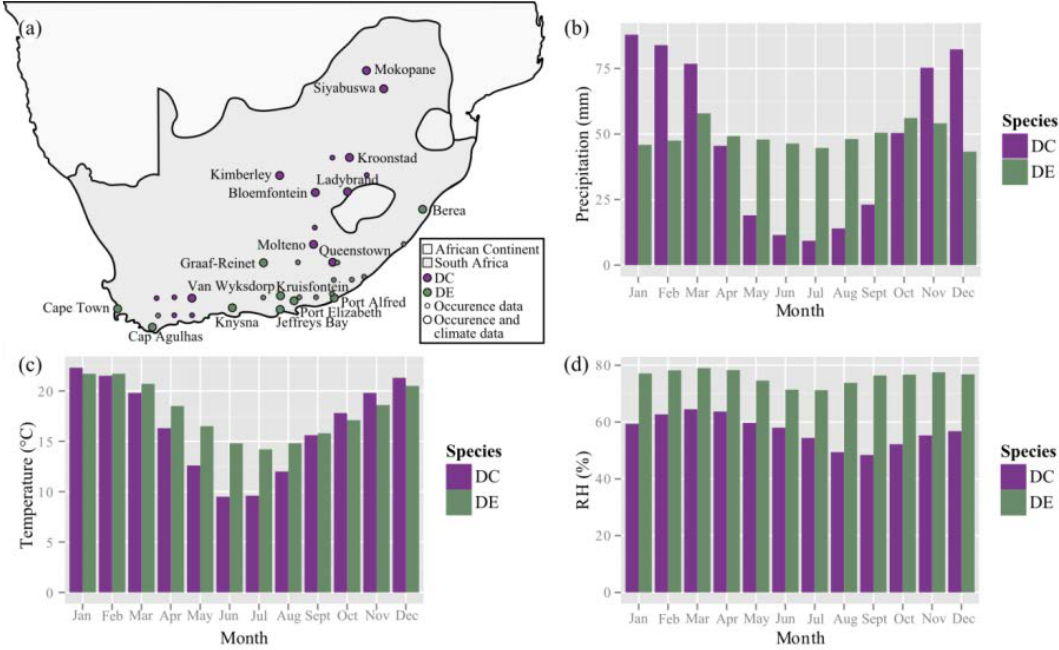
Figure 10. Occurrence and climate data of D . cooperi (DC) and D . ecklonis (DE). ( a ) Map of Southern Africa (light grey) and South Africa (dark grey) mapping the natural occurrences of D . cooperi and D . ecklonis . The larger dots mark locations from which climate data were acquired. ( b ) Monthly precipitation (mm), ( c ) monthly temperature (°C) and ( d ) monthly relative humidity (RH in %). The climate data for a given city originate from an average of 18–112 years on record for each city of occurrence of each species.